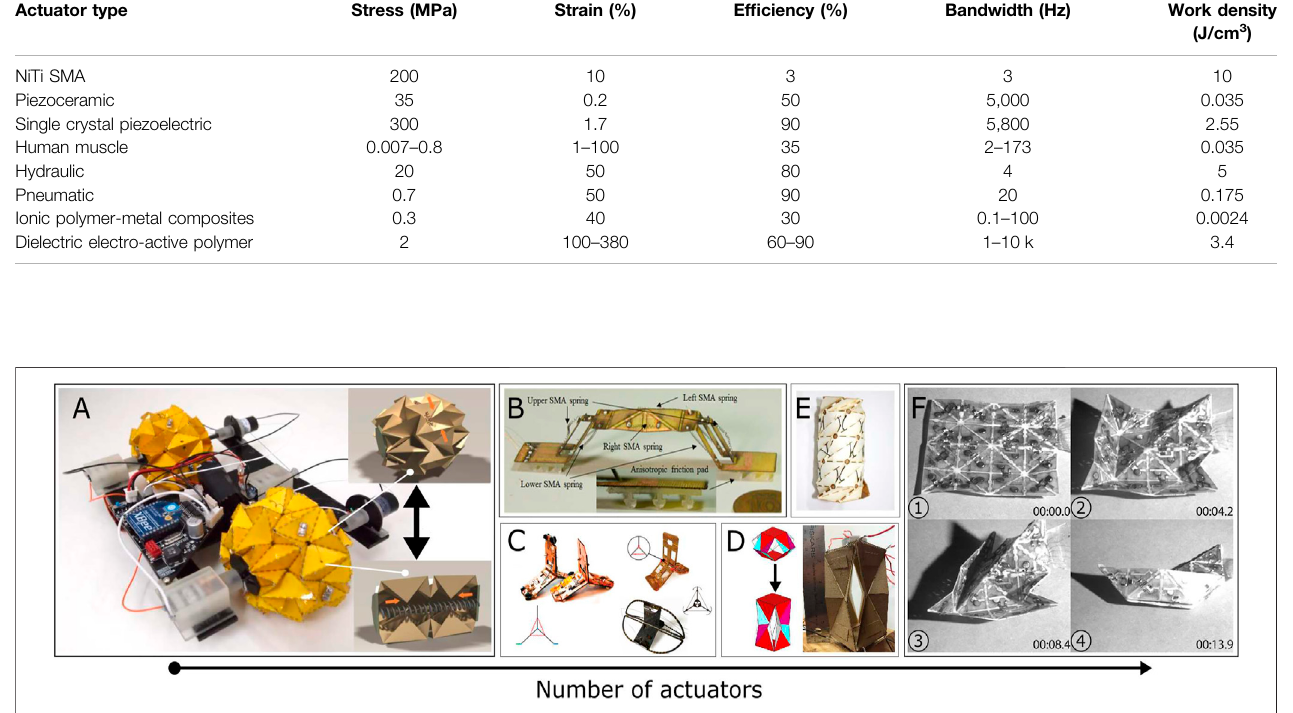
TABLE 1 | Comparison of actuators performance, inspired from Bhandari et al. (2012), Mohd Jani et al. (2014), Wang et al. (2018). Actuator type